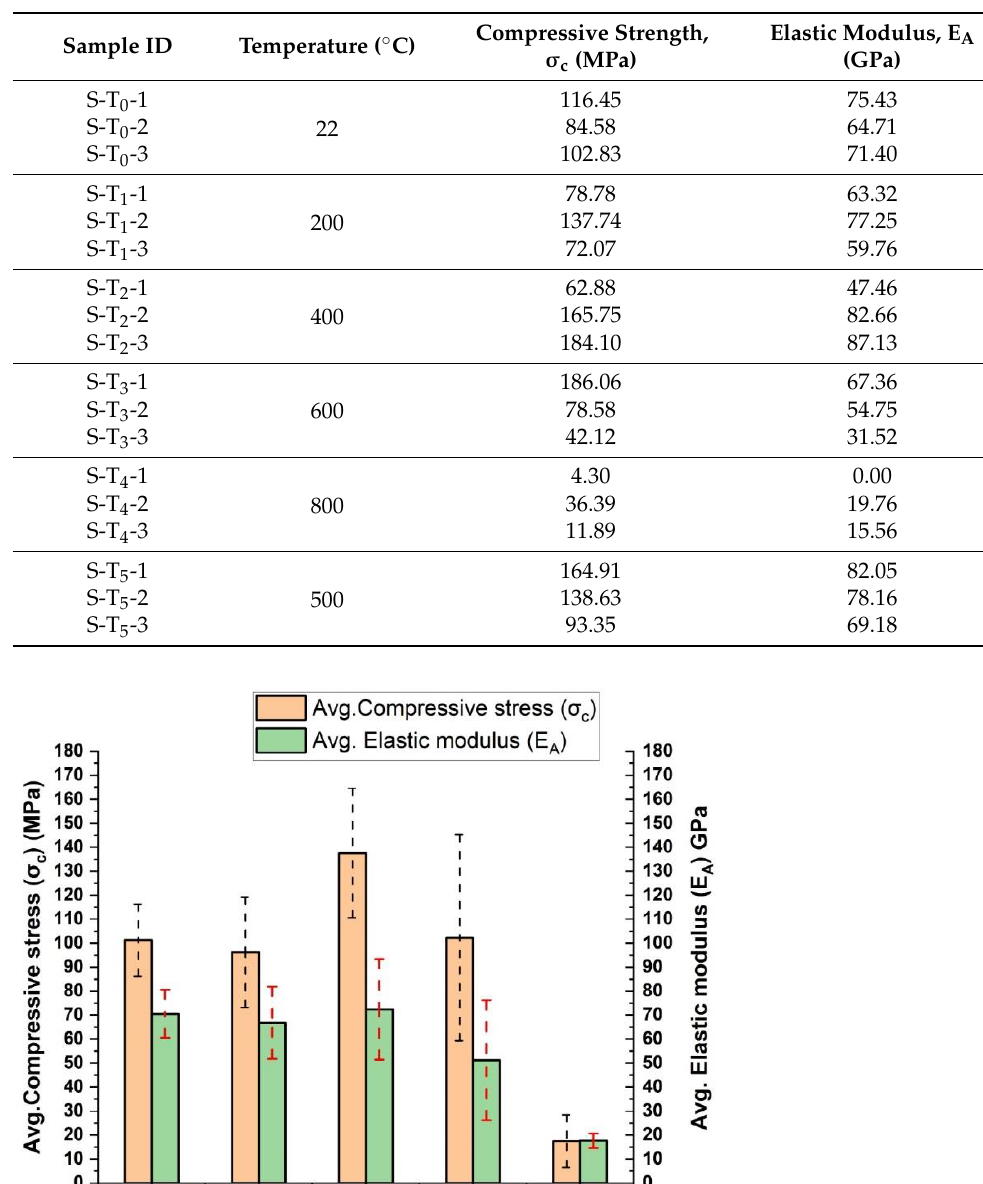
Table 5. Results of UCS and elastic modulus of the specimens.